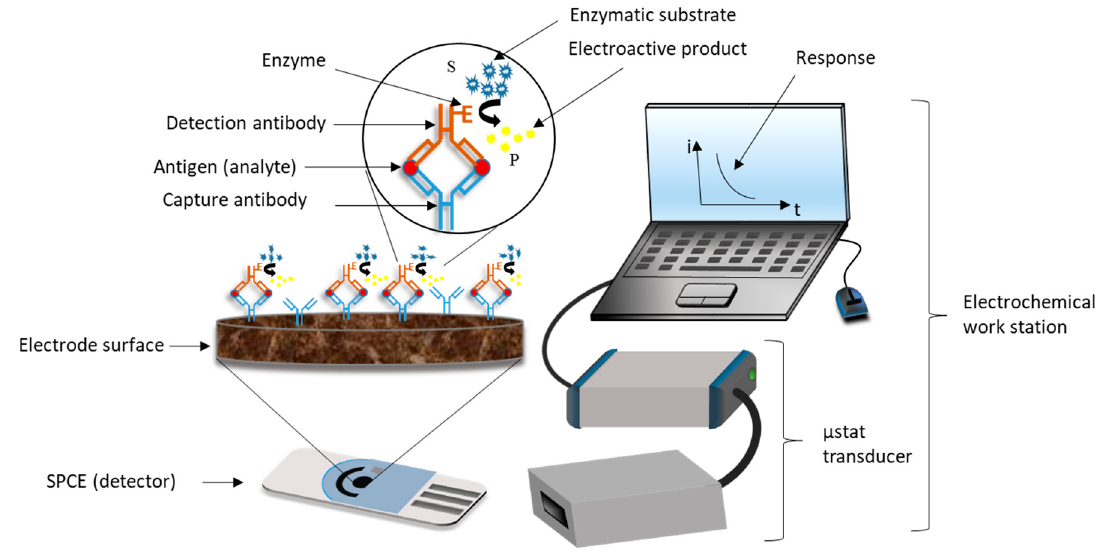
Figure 2. Basic analytical principle of an ELISA sandwich amperometric immunosensor using screen printed carbon electrodes (SPCEs) [32].